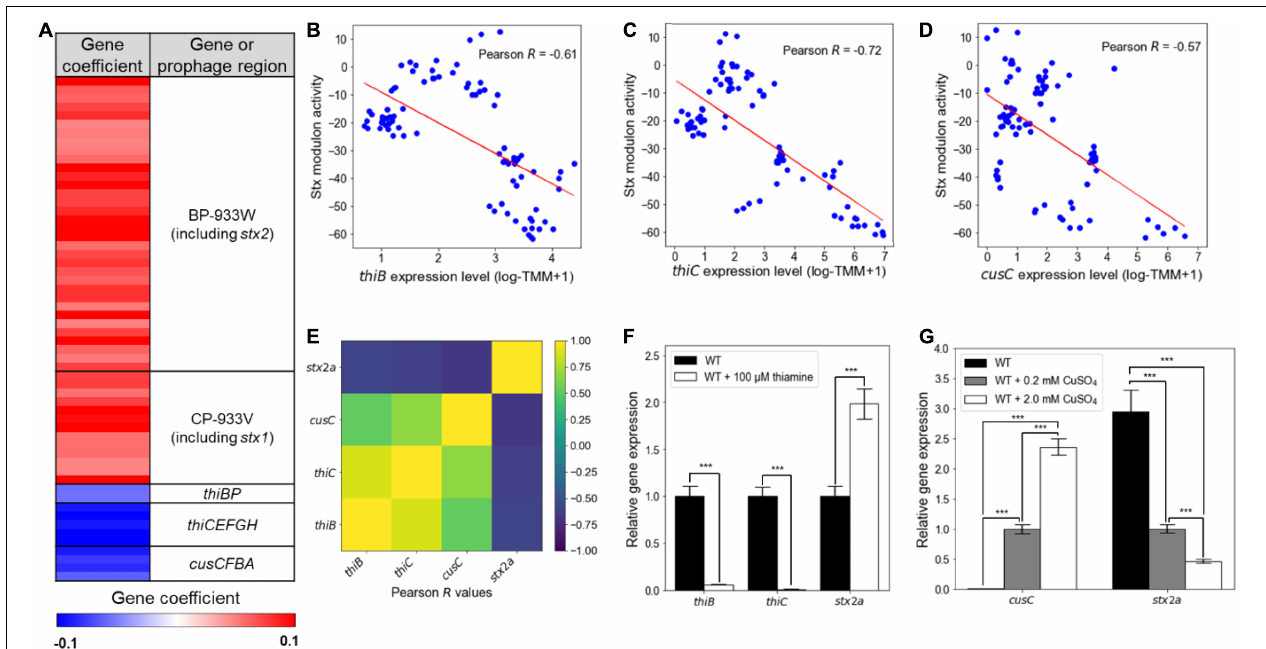
FIGURE 3 | The contrary expression patterns of the thi and cus locus genes to those of the Stx prophage genes. (A) Heatmap for the gene coefficients in the Stx modulon. Red and blue represent the high (+0.1) and low (–0.1) gene coefficient, respectively. The scatter plots of the activities of the Stx modulon and the expression levels of thiB (B) , thiC (C) , and cusC (D) . Each dot of the plots represents a single biological replicate. Red lines represent the regression lines of the plots. The Pearson R values between the activities of the Stx modulon and the expression levels of each gene of the plot are denoted in the boxes. (E) Ordered correlation matrix. Colors indicate the Pearson R values between the expression levels of thiB , thiC , cusC, and stx2a, as indicated. Yellow and indigo represent the strongest positive (+1) and negative (–1) correlation, respectively. (F,G) The relative expression levels of genes of interest in the WT grown under the different levels of thiamine and copper ions. The transcript levels of thiB , thiC , and stx2a in the WT with or without thiamine were determined by qRT-PCR, and the transcript levels of each gene in the WT were set to 1 (F) . The transcript levels of cusC and stx2a in the WT with the different levels of CuSO 4 were also determined by qRT-PCR, and the transcript levels of each gene in the WT with 0.2 mM CuSO 4 were set to 1 (G) . Error bars represent the SD from four independent experiments. Statistical significance was determined by the Student’s t -test (*** P < 10 − 3 ). WT,